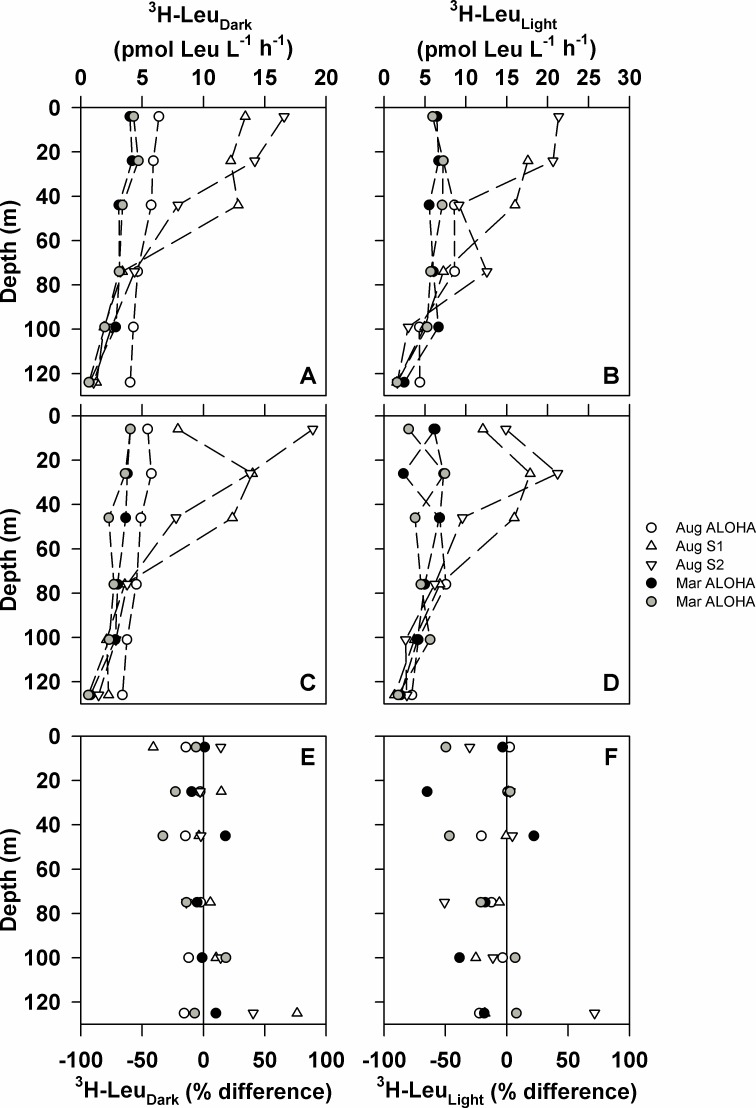
Depth-resolved rates of 3H-Leu incorporation in August 2010 and March 2011.Rates of 3H-Leu incorporation (pmol Leu L-1 h-1) in the dark for both ambient and elevated seawater pCO2 (~390 and 750 μatm, respectively) are shown (panels A and C, respectively), as are rates in the light for both ambient and elevated pCO2 (panels B and D, respectively). Also shown are percent differences between treatments ([treatments—controls] / controls) for 3H-LeuDark incorporation (panel E) and 3H-LeuLight incorporation (panel F).